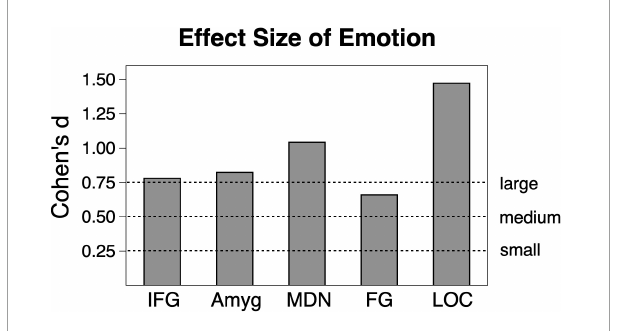
FIGURE2 Emotional vs. neutral contrast Cohen’s effect size across the sample ( n = 23) in the five regions of interest. Amyg, amygdala; FG, fusiform gyrus; IFG, inferior frontal gyrus/anterior insula; MDN, medial dorsal nucleus of the thalamus; LOC, lateral occipital cortex.